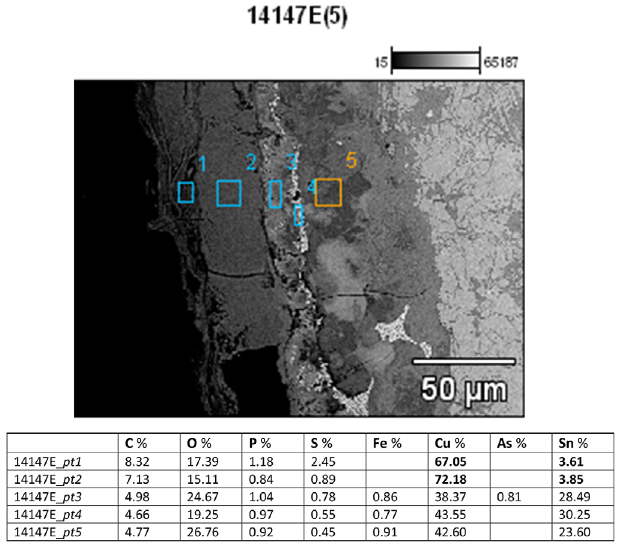
Figure 6. Specimen sample from the end part of the collar near Lüneburg (LMN 14147). The SEM data clearly show a severe element composition at the outer layer of the collar (scan: Dirk Kirchner, German Mining Museum, Bochum).